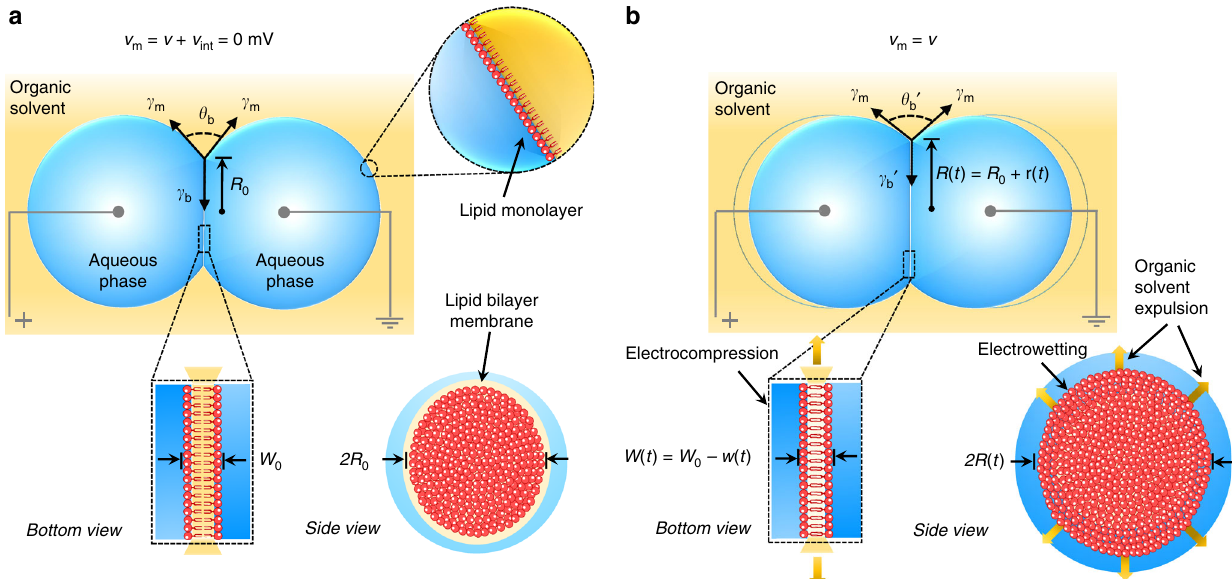
Fig. 1 Biomimetic membrane assembly and electromechanical behaviours. a A capacitive planar lipid bilayer that mimics the structure of a biological membrane forms spontaneously upon contact between lipid-coated droplets and exclusion of excess oil. The elliptical interface represents an equilibrium in adhesive forces governed by: (1) a balance of monolayer, γ m , and bilayer, γ b ; tensions prescribed by Young ’ s equation (Supplementary Note 2, Eq. S.2); and (2) the slight sagging of droplets caused by the water-oil density difference. In the absence of a net membrane voltage, the geometry of the bilayer is described by the zero-volt minor axis radius, R 0 (~100 – 300 µ m, determined by analysis of bottom-view, bright- fi eld images (Supplementary Fig. 2), and the hydrophobic thickness, W 0 (~2 – 4 nm). Wire-type (~125 µ m diameter) silver/silver chloride (Ag/AgCl) electrodes inserted into the droplets were used to apply a transmembrane voltage and measure the induced ion current. Aqueous droplets (pH 7) contained 500 mM potassium chloride and 10 mM MOPS (3-(N-morpholino)propanesulfonic acid). We de fi ne the membrane voltage, v m , as the summation of the applied voltage, v(t) , and the intrinsic membrane potential, v int (equal to zero for symmetrical membranes). b A schematic describing the geometrical changes caused by a net membrane voltage, v ( t ). Changes are manifested by EW-driven creation of new bilayer area between opposing lipid monolayers (at constant thickness) and an independent decrease in hydrophobic thickness due to EC-driven removal of residual oil in the membrane. Since the volumes of both droplets remain constant, the external contact angle, θ b ′ , and bilayer radius, R ( t ), increase as EW reduces bilayer tension, γ ′ b . Monolayer tension, γ m , is independent of transmembrane voltage (Supplementary Fig.